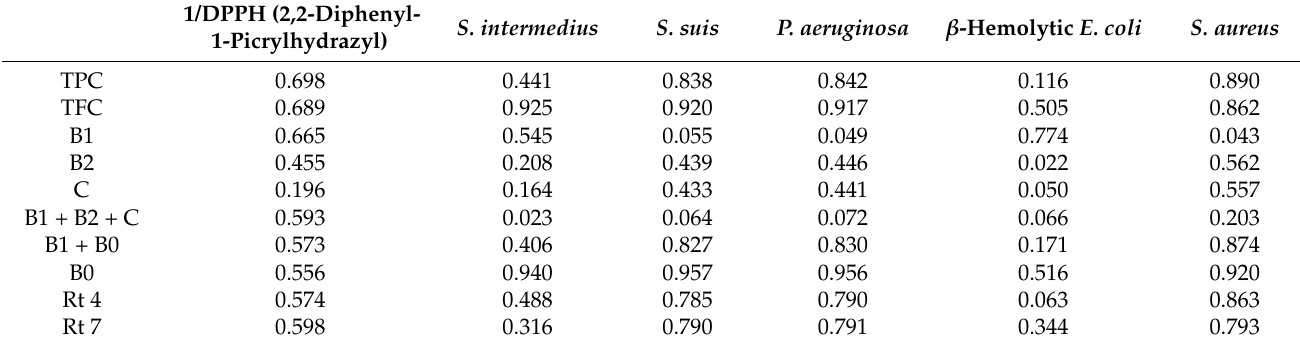
Table 5. The R Values (Correlation Coefficients) between the Antioxidant (1/EC 50 , µ g/mL) and Antibacterial Activities (Zone of Inhibition, mm) and Total Phenolic Contents (g% GAE), Total Flavonoid Contents (g% QE) and the Peak Areas of flavones in O . indicum